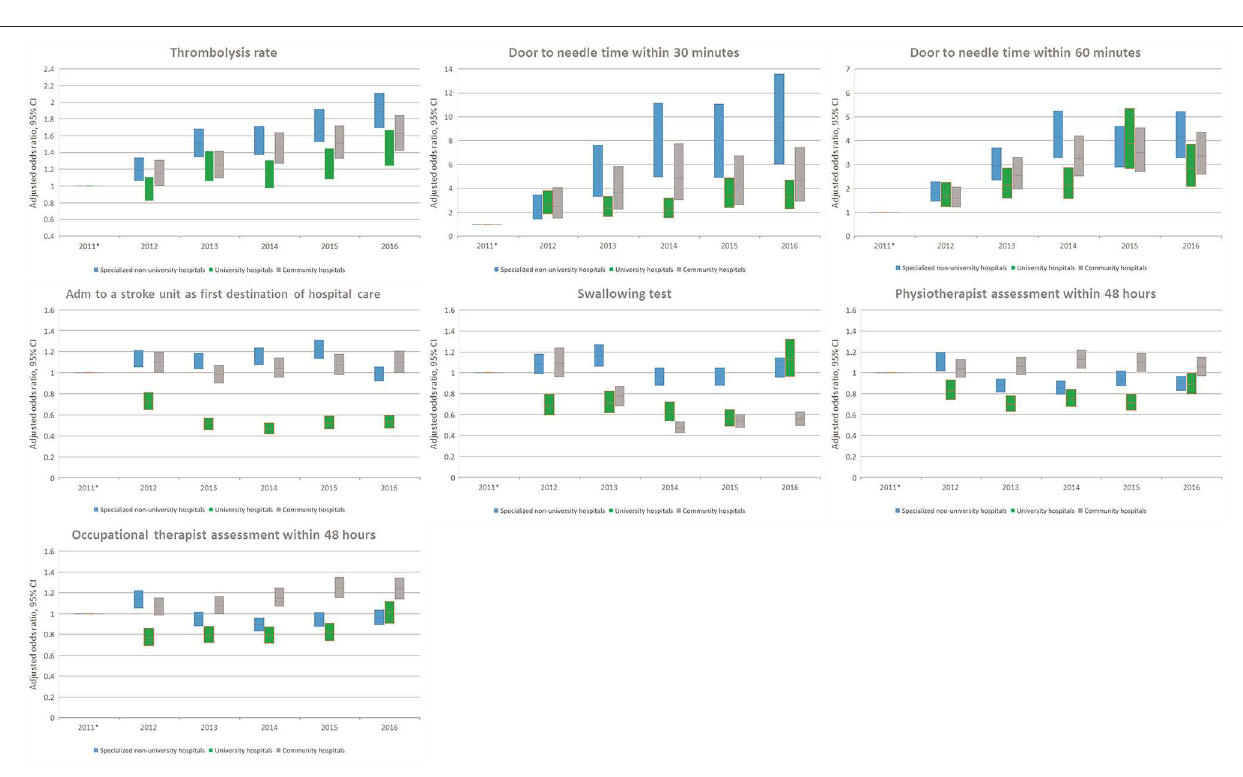
FIGURE 8 | Adjusted analyses per year stratified by hospital type. OR with 95% confidence intervals for each hospital type. Only outcomes with significant interaction terms are included.